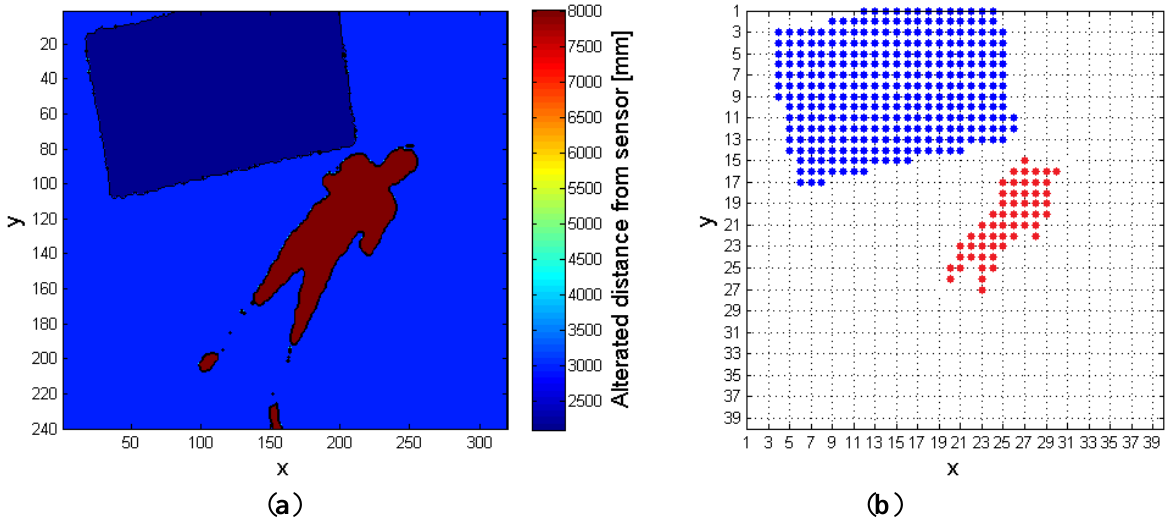
Figure 10. Time sequence of the depth values assumed by the person’s central point ( cp parameter), with fall event detected and highlighted in